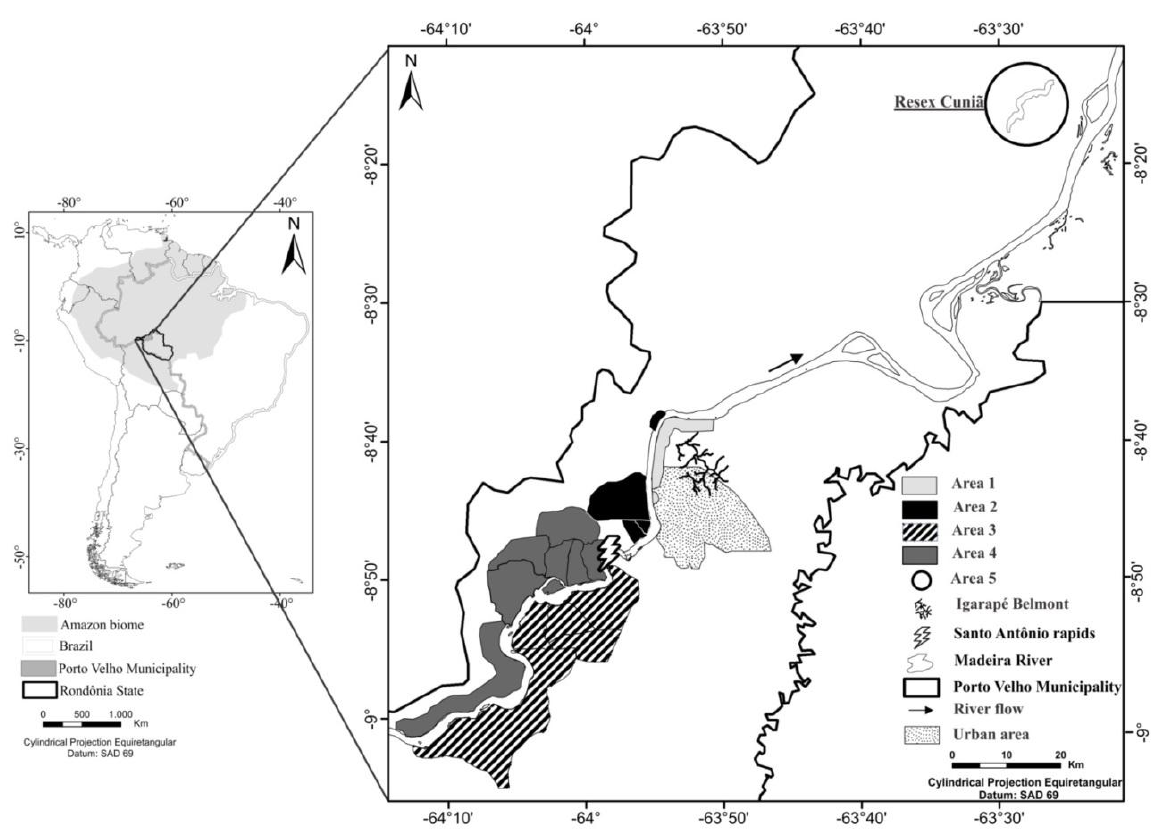
Figure 1. Illustration of the study area showing riparian communities regarding their proximity and location around the Santo Antônio falls. Area 1 (downstream the rapids, right bank), Area 2 (downstream the rapids, left bank), Area 3 (upstream the rapids, right bank), Area 4 (upstream the rapids, left bank) and the extractive reserve of the Cuniã Lake (Area 5), about 180 km downstream the rapids. Porto Velho city is the capital of Rondônia